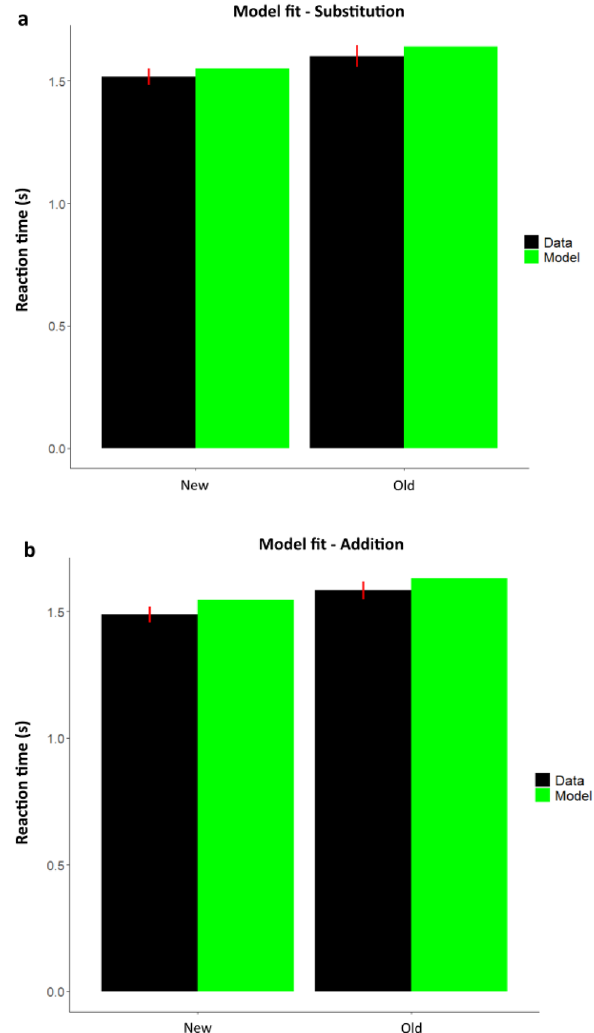
Figure 7. Model accurately fits the observed RT ( a ) Reaction time fits of the model with empirical RT data in Substitution for New sequence (left) and Old sequence (right). ( b ) Reaction time fits of the model with empirical RT data in Addition for New sequence (left) and Old sequence (right). Data (Black), Model (Green). Error bars represent SEM for the RT data.